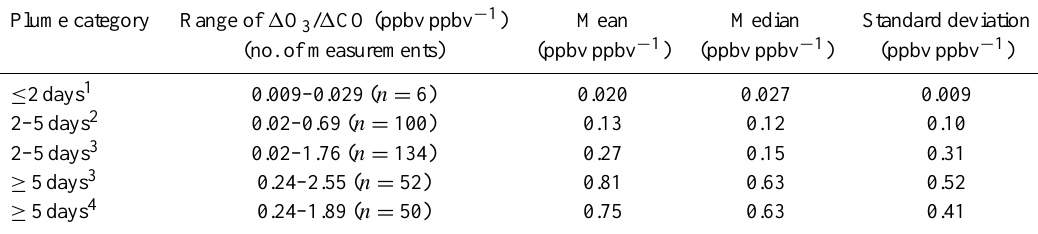
Table 2. Observed 1 O 3 / 1 CO in biomass burning plumes sampled during BORTAS filtered by photochemical age, following Jaffe and Wigder (2012).